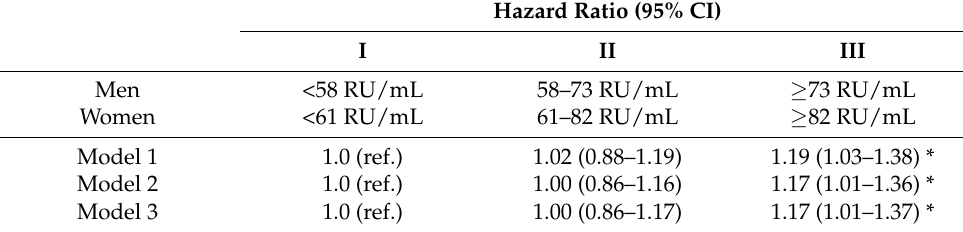
Table 4. Associations between fibroblast growth factor 23 and risk of incident hypertension in 3720 PREVEND participants.